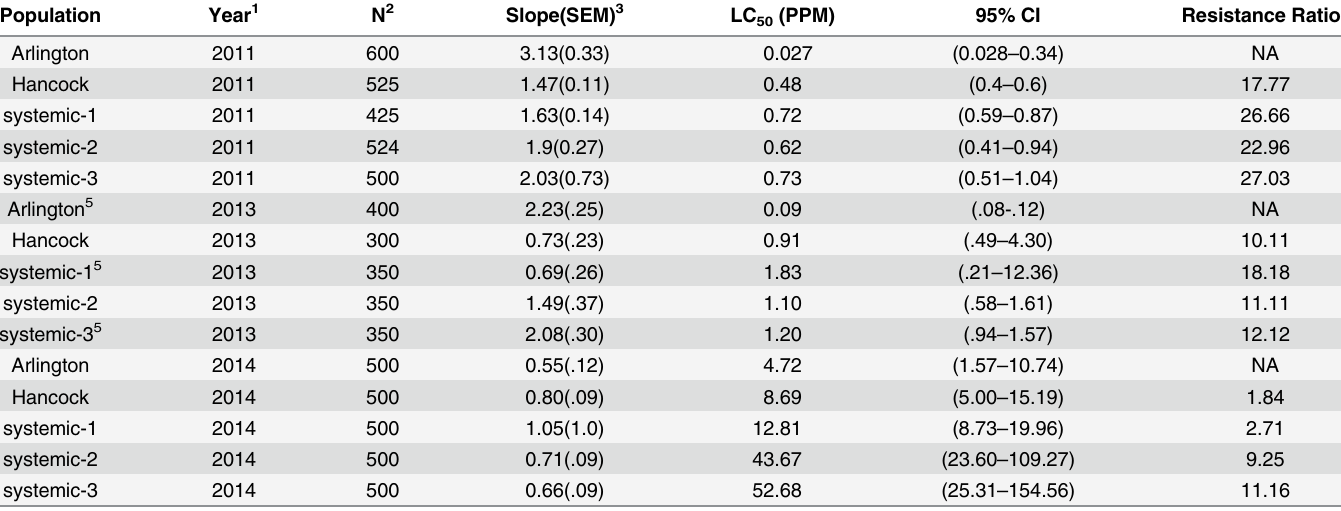
Table 2. Regression estimates resulting from topical bioassays of adult Leptinotarsa decemlineata at the Arlington (AARS) and Hancock Agricul- tural Research Stations (HARS), plus agricultural fields classified as systemic-1, 2 and 3 in 2011, 2013 and